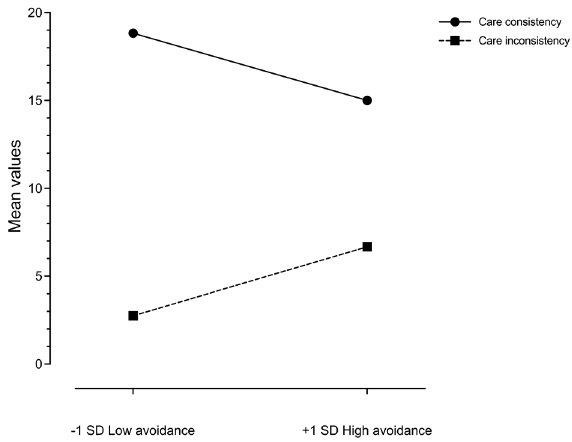
Figure 2. Means of care-consistency and care-inconsistency choices at − 1 SD and + 1 SD of avoidance scores.